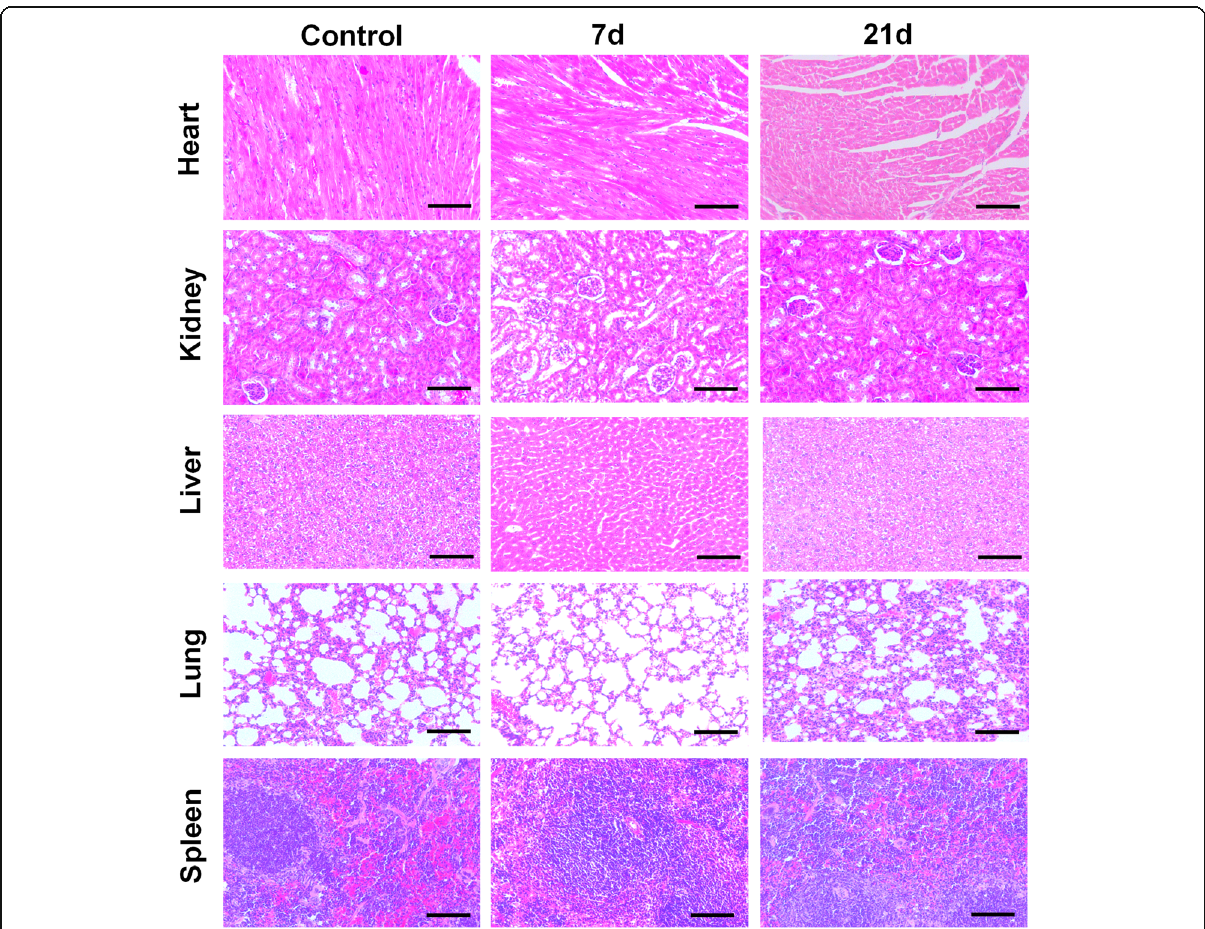
Fig. 6 Histological analysis of major organs after 7 and 21 days administration of CDs. Scale bar = 100 μ